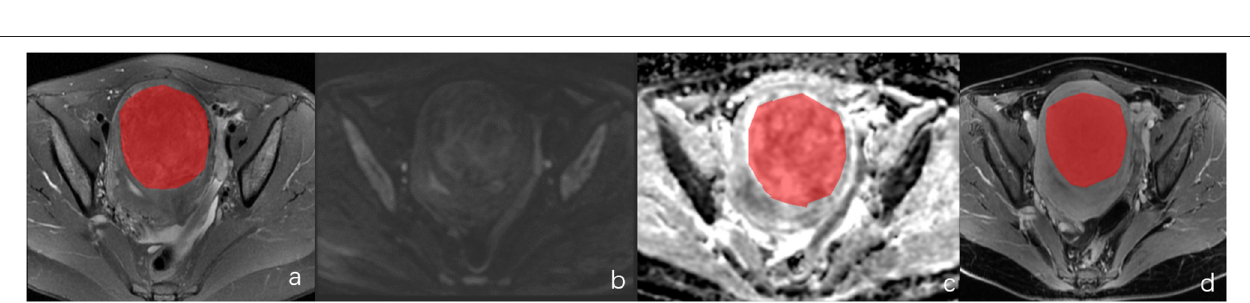
FIGURE 1 | A female of 60 years with endometrial mesenchymal sarcoma. (a–d) represented the localization of the lesion on DWI and the ROI selection schematic for T2WI, ADC and T1CE, respectively.